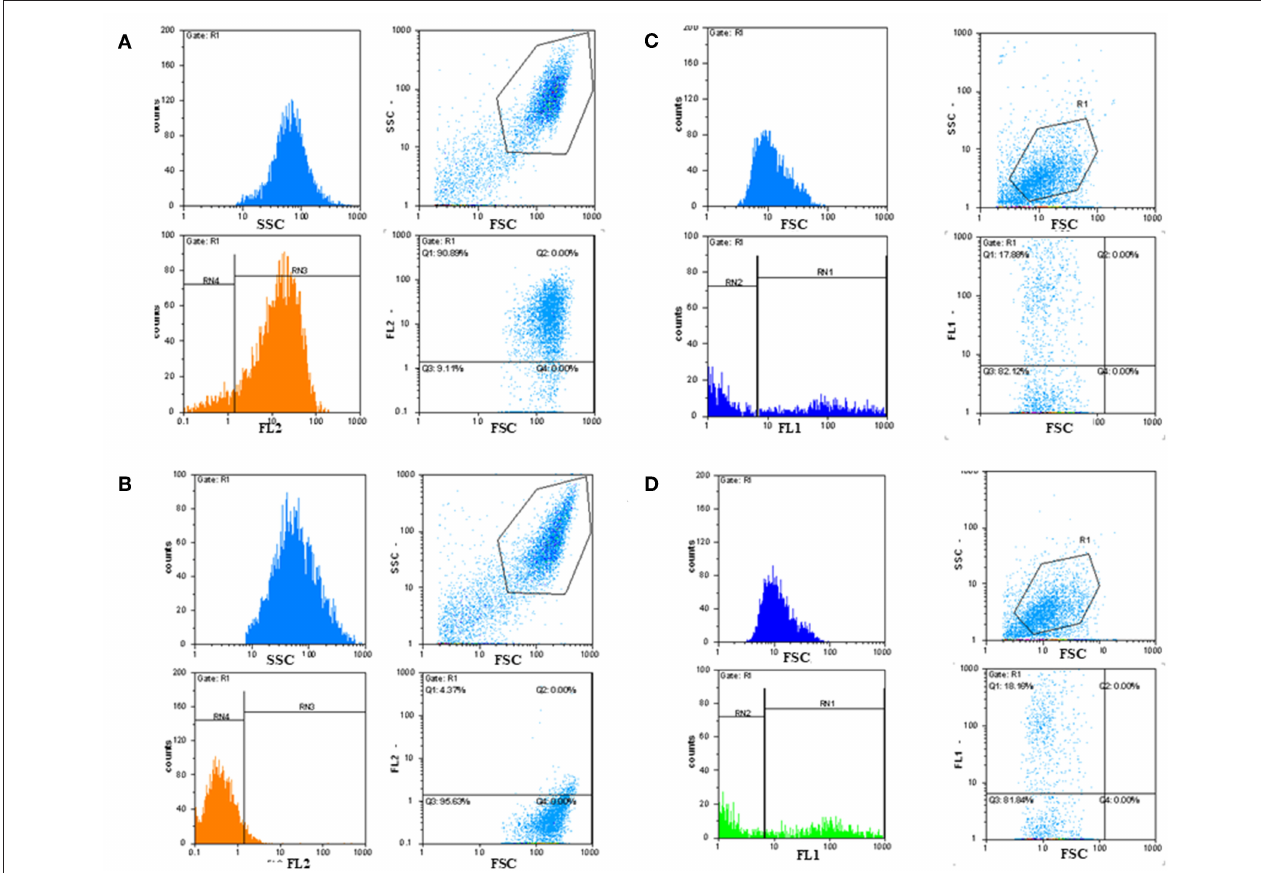
FIGURE 8 | Detection of GD3 ganglioside positive cancerous cells by immunofluorescence FACS analysis. Indirect immunofluorescence assay and FACS analysis showed that tumor-associated disialylated glycosphingolipid specific antibodies reacted intensively with primary cancerous cell outgrowth from metastatic melanoma (A) , The majority (90%) of this cell population was GD3 ganglioside positive. Mean fluorescence intensity was about 100 times higher than the value of the negative control (B) . IF FACS analysis proved strong binding capacity of our scFv anti GD3 antibody fragments against the cultured A2058 melanoma cells (C,D)